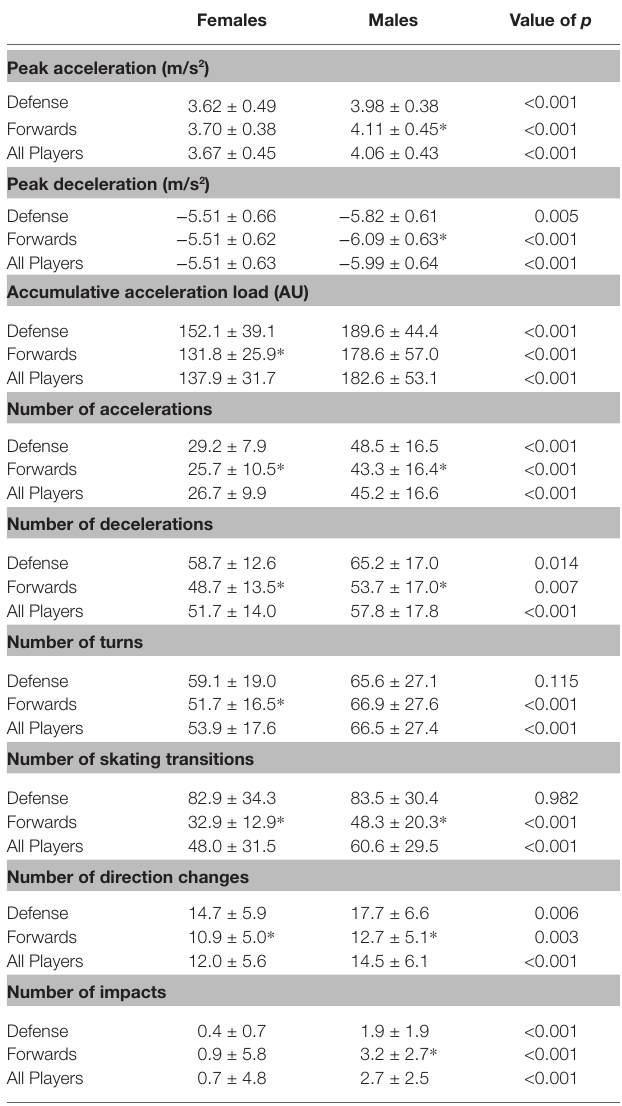
Data are presented as means ± SD. Values of p represent comparisons of means between males and females within the same position. * Represents a significant difference between defense and forwards (p <